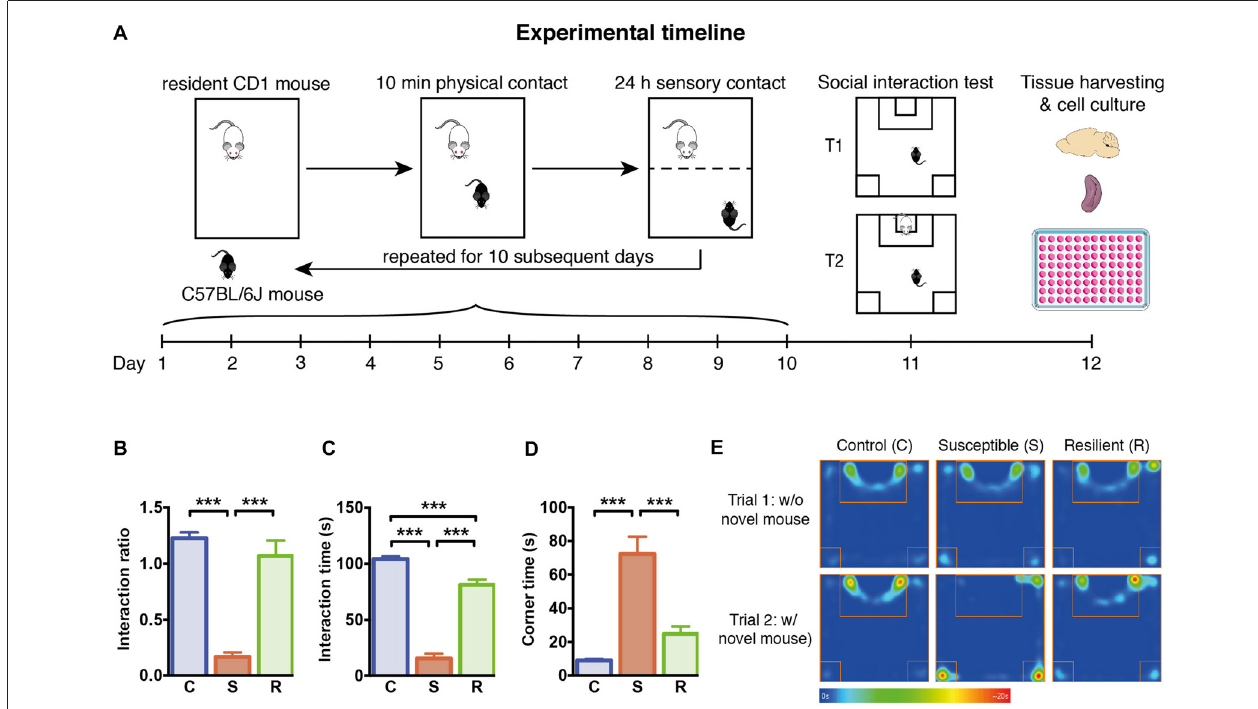
FIGURE 1 | Experimental timeline and social behavior. (A) Graphical representation of the experimental timeline. C57BL/6J mice were subjected to 10 min daily confrontation with CD-1 mice for 10 subsequent days. In between, mice were housed in the same cages separated by a perforated Plexiglas wall from the dominant and aggressive conspecific. At day 11, mice were tested in the social interaction test, before they were sacrificed 1 day later for tissue harvesting and cellular analysis. (B) Significantly reduced interaction ratio in susceptible mice calculated as time spent in the interaction zone in trial 2 in relation to the time in trial 1. (C) Significantly decreased time spent in the interaction zone during the 2nd trial of the social interaction test in susceptible mice. (D) Significantly increased time spent in the corners opposite to the interaction zone during the 2nd trial of the social interaction test in susceptible mice. (E) Mean heat map of the groups’ center points for control, susceptible and resilient mice in the 1st and 2nd trial of the social interaction test. Bar graphs represent mean + SEM. T1, trial 1; T2, trial 2; C, control; S, susceptible; R, resilient. n C = 16, n S = 15, n R = 15. ∗∗∗ p < 0.001.